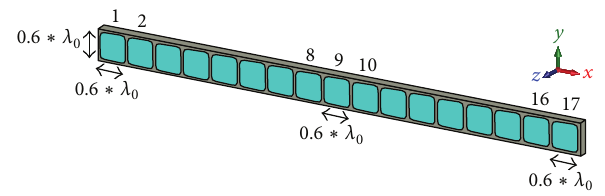
Figure 3: The designed prototype of 1D matrix antenna formed by 17 jointed pixels linearly spaced by 0.6 ∗ 𝜆 0 .